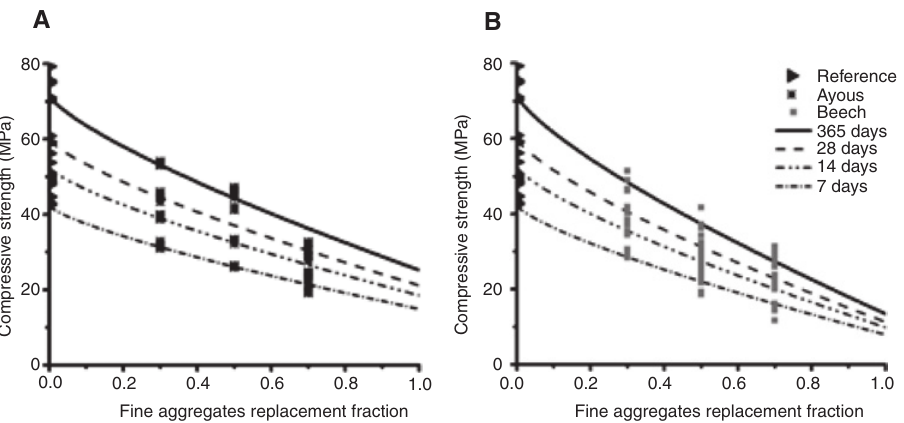
Figure 8: Compressive strength versus fine aggregates replacement fraction (A) only for ayous wood shavings and (B) only for beech wood shavings.